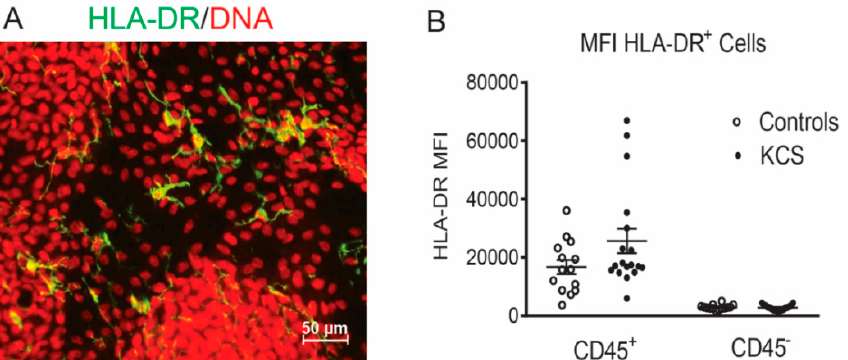
Figure 2. HLA-DR intensity in gated CD45 + cells. ( A ) Merged image of laser confocal micrograph of dendritic cells (DC) in human conjunctival impression cytology from a normal subject stained with HLA-DR (green) and nuclei stained with red propidium iodide. ( B ) Mean fluorescent intensity (MFI) of HLA-DR + cells in CD45-gated cell population obtained by conjunctival impression cytology from controls ( n = 7) and KCS subjects ( n = 9). Data shown as scatter plots with mean ± SD.